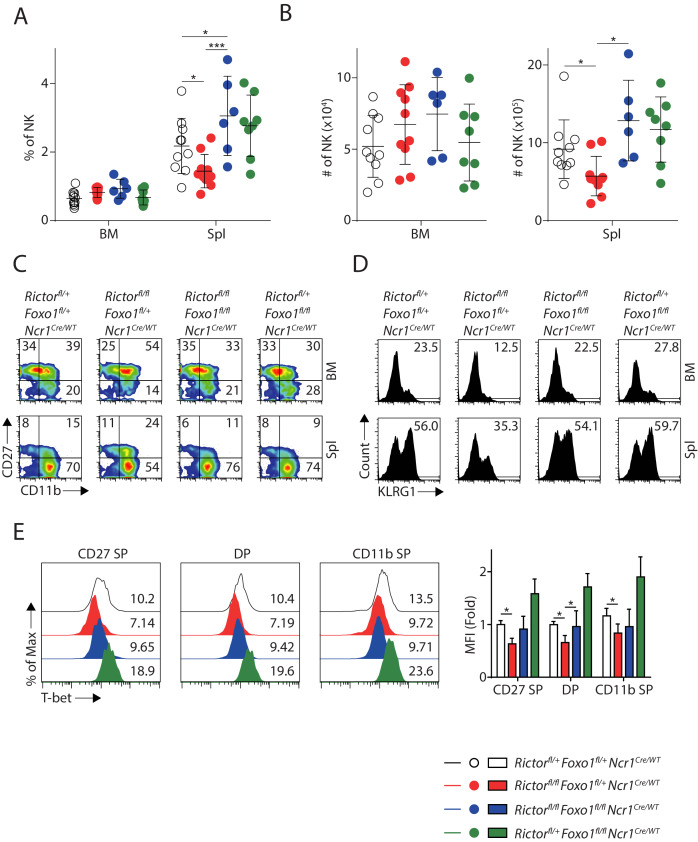
Deletion of Foxo1 rescues the NK cellularity and maturation defects in Rictor cKO mice.(A) Quantification of the percentage of NK cells in the BM and spleen of the four group mice (gated on CD3ε−NCR1+). Pooled from eight independent experiments. (B) Quantification of the absolute number of NK cells in the BM and spleen of the four group mice (gated on CD3ε−NCR1+). Pooled from eight independent experiments. (C, D) Representative flow plots demonstrating the expression of CD27/CD11b (C) and KLRG1 (D) in the NK cells from BM and spleen of the four group mice (gated on CD3ε−NCR1+). (E) The protein level of T-bet in three NK subsets defined by the expression of CD27 and CD11b were evaluated by intracellular staining and gated on CD3ε−NCR1+ cells from spleen of the four group mice. The representative flow plots were shown on the left. The mean fluorescent intensity (MFI) of T-bet was quantified and shown as fold-change normalized to the CD27 SP population from WT control as shown on the right. n ≥ 3, pooled from three independent experiments. Statistical significance was calculated using Two-way ANOVA. The data from Rictorfl/+Foxo1fl/flNcrCre/WT mice were not included in the statistical analysis for Figure E. *p<005; **p<0.01; ***p<0.001.